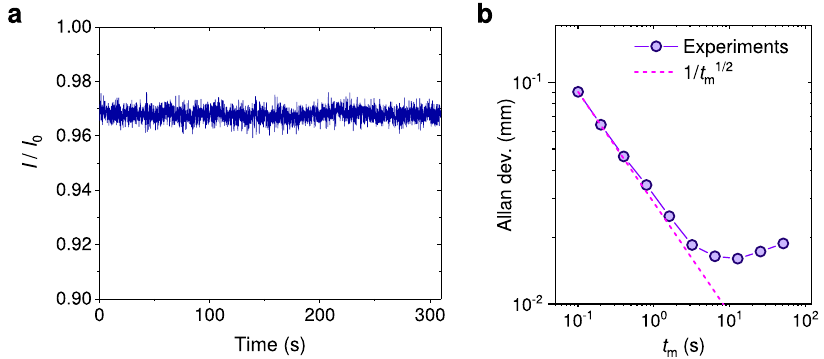
Fig. 4 | The estimation of RF ranging accuracy. a Time trace of the normalized ranging signal with N =4. The con fi guration of RF pulse is set to obtain a local maximum optical response dI / dL , as that in Fig. 3d. b Allan deviation of the data in ( a )decreaseswiththe measurementtime t m .Thedeviationofrangingiscalculated